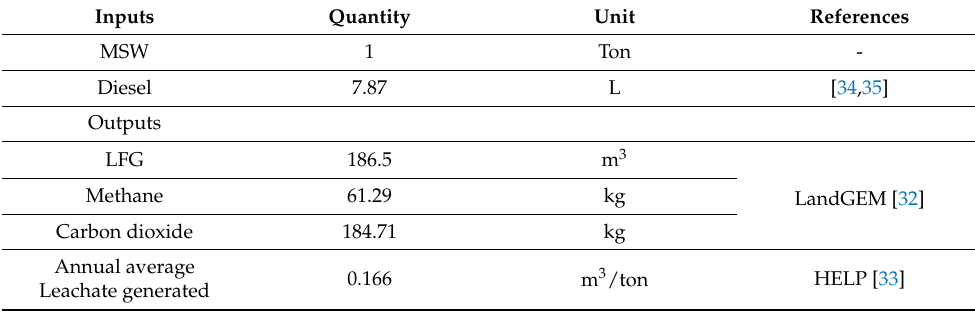
Figure 2. Landfill gas generation using LandGEM. Table 2. Life cycle inventory of MSW